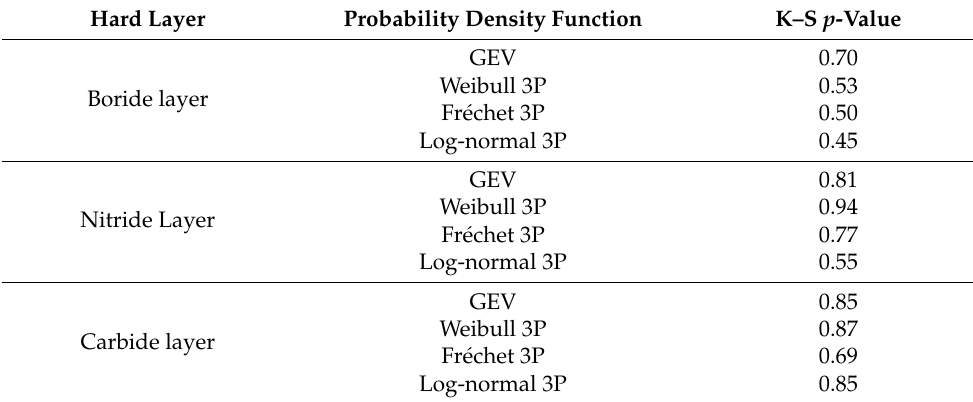
Table 10. Thickness layer observations fitted to probability density